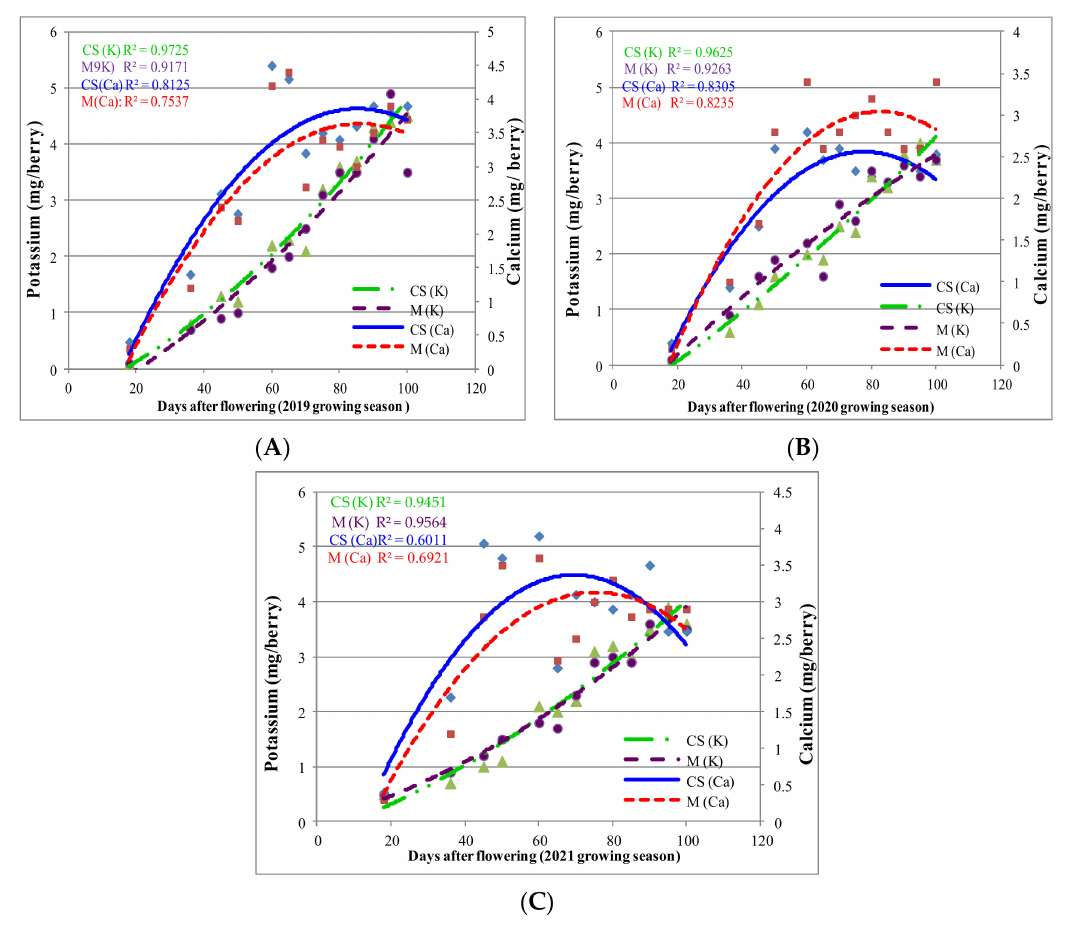
Figure 3. K and Ca accumulation in ‘Cabernet Sauvignon’ (CS) and ‘Merlot’ (M) berries during 2019–2021 growing seasons ( A – C ), from flowering to maturity. A scatterplot with a trend line of different colour and dash type was drawn to represent the relationships between DAF, Ca and K accumulation in the CS and M berries, during 2019–2021 growing seasons. The regression analysis suggests that Ca and K accumulation changes with DAF ( —K in CS berry; —K in M berry; —Ca in CS berry; —Ca in M